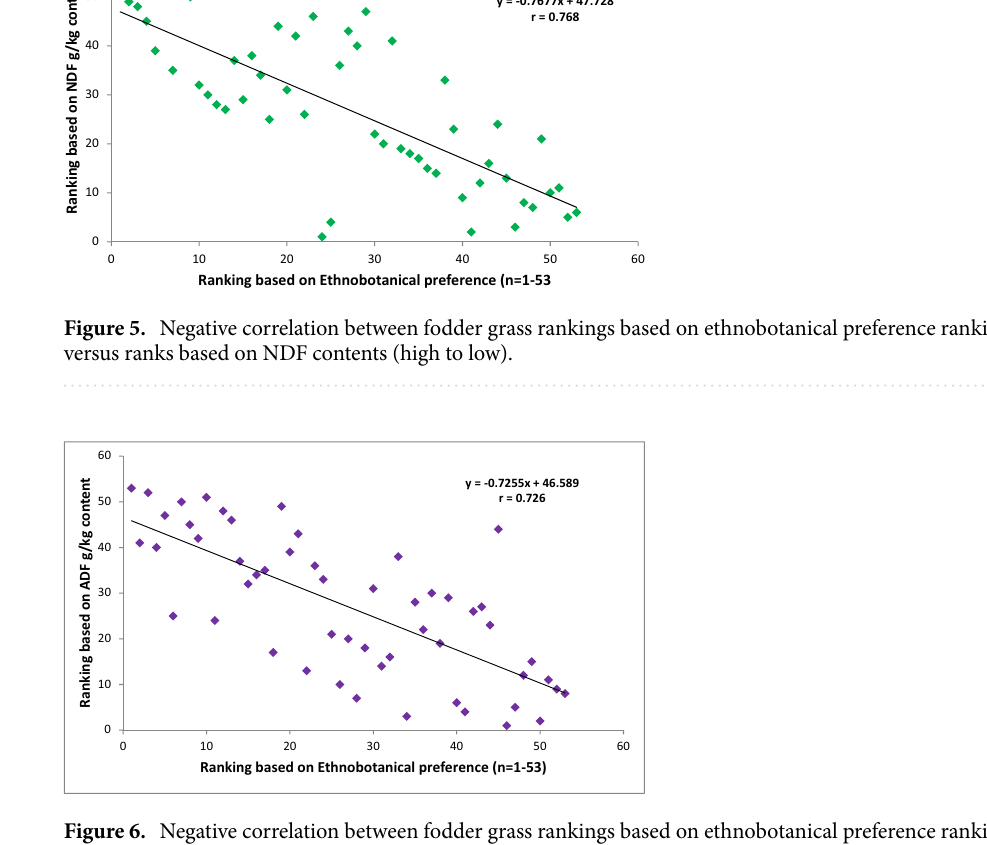
y = -0.7677x + 47.728 r = 0.768